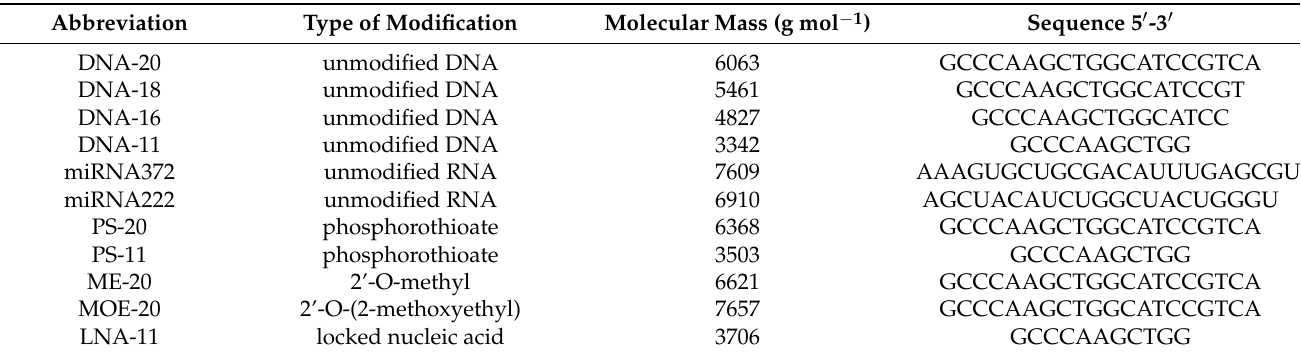
Table 1. The oligonucleotides used in this